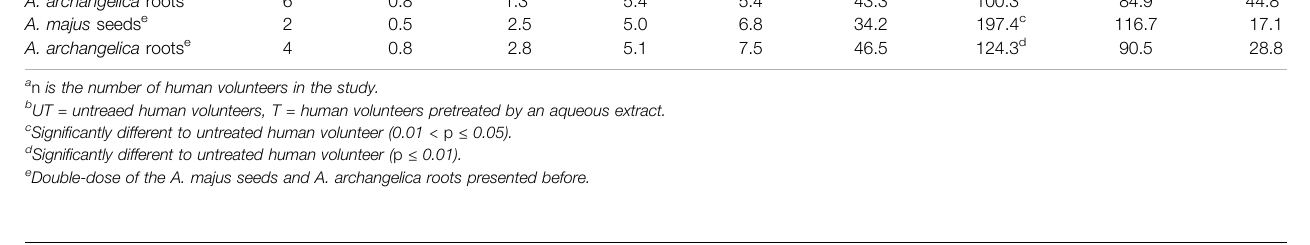
TABLE 4 | Caffeine pharmacokinetic parameters of human volunteers before and after pre-treatment with the water extract of P. aniseum , P. crispum , A. pubescens , A. graveolens seeds, or A. graveolens fl akes. The ± SD of the data is omitted for better display and comparison. Plant product